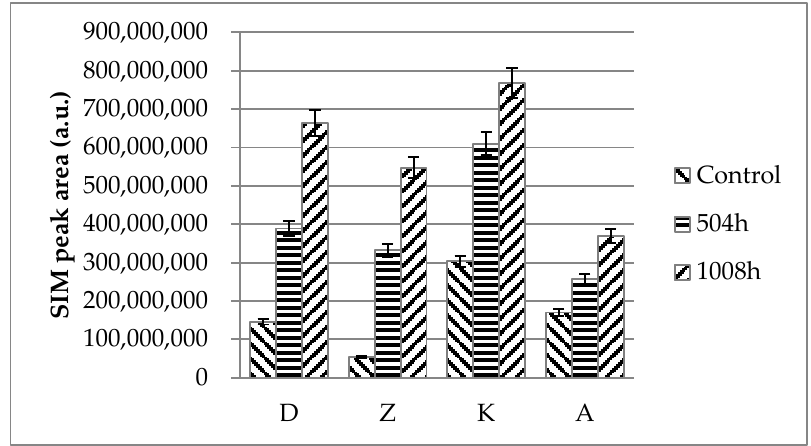
Figure 5. Pyrolysis-gas chromatography/mass spectrometry-selected ion monitoring (py-GC/MS-SIM) peak area corresponding to 1,6-hexanediamine in PA66/GF composites with respect to immersion time.